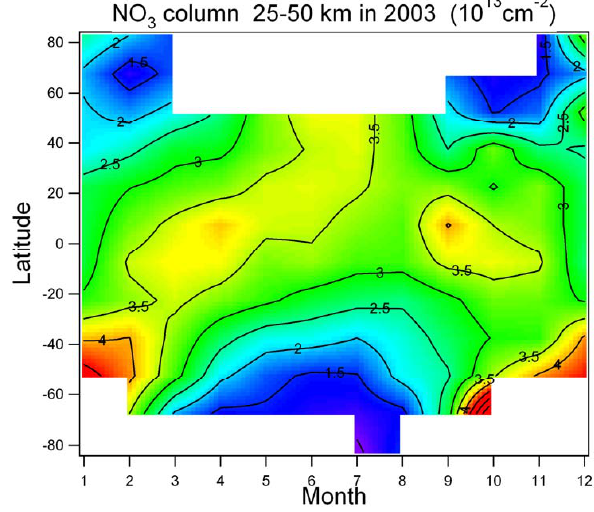
Fig. 33: Time-latitude cross section of NO 3 stratospheric column (25–50 km) in 10 13 cm -2 in 2003, derived from GOMOS vertical profiles (from Hauchecorne et al., 2005). Fig. 33. Time-latitude cross section of NO 3 stratospheric column (25–50km) in 10 13 cm − 2 in 2003, derived from GOMOS vertical profiles (from Hauchecorne et al.,